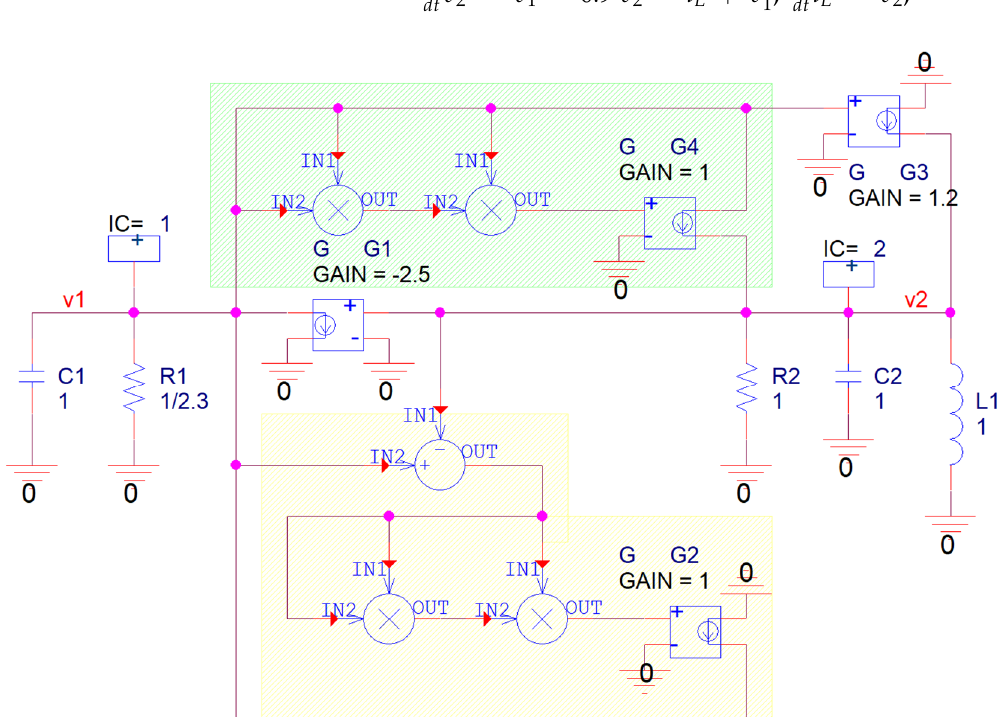
Figure 10. Maximally idealized third-order dynamical system, circuit realization using pseudo-components MULT (multiplication of two input voltages) and voltage-controlled current-sources G.